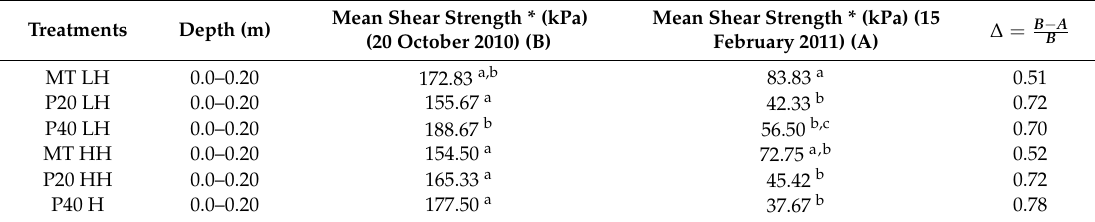
Table 3. Mean values from 0 to 0.20 m depth for shear strength carried out before (B) and after (A) tillage and its increment ratio ∆ .